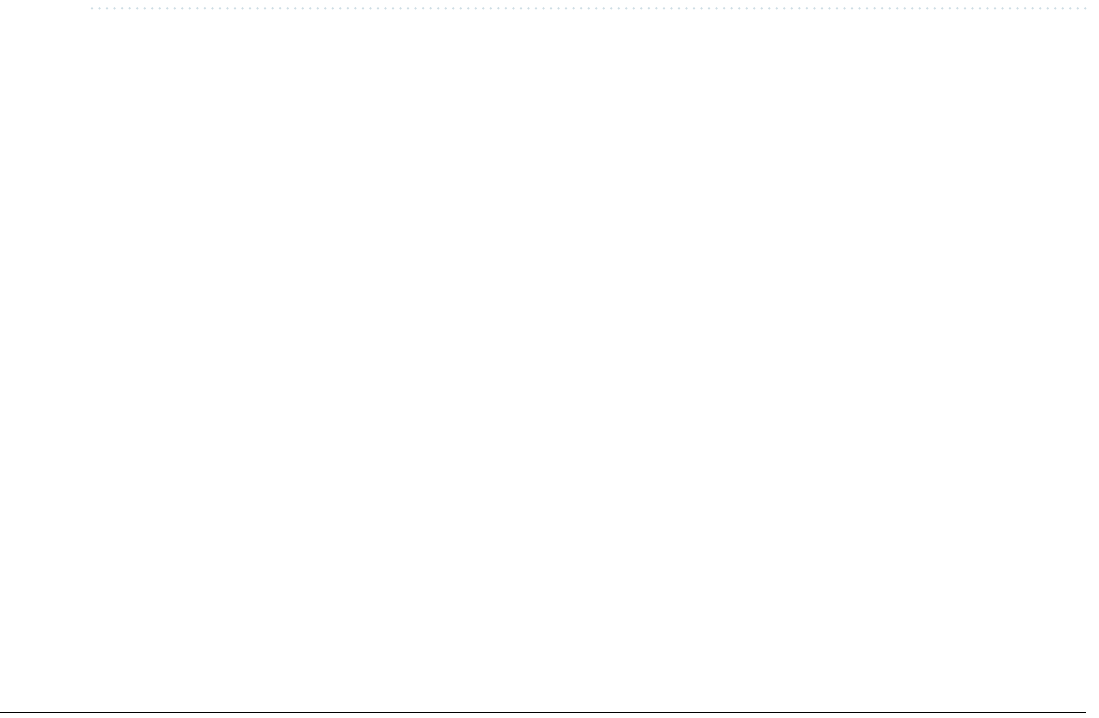
Figure 8. Real and predicted trajectories, ( a ) daily new coronavirus cases, ( b ) daily new dead and ( c ) daily new